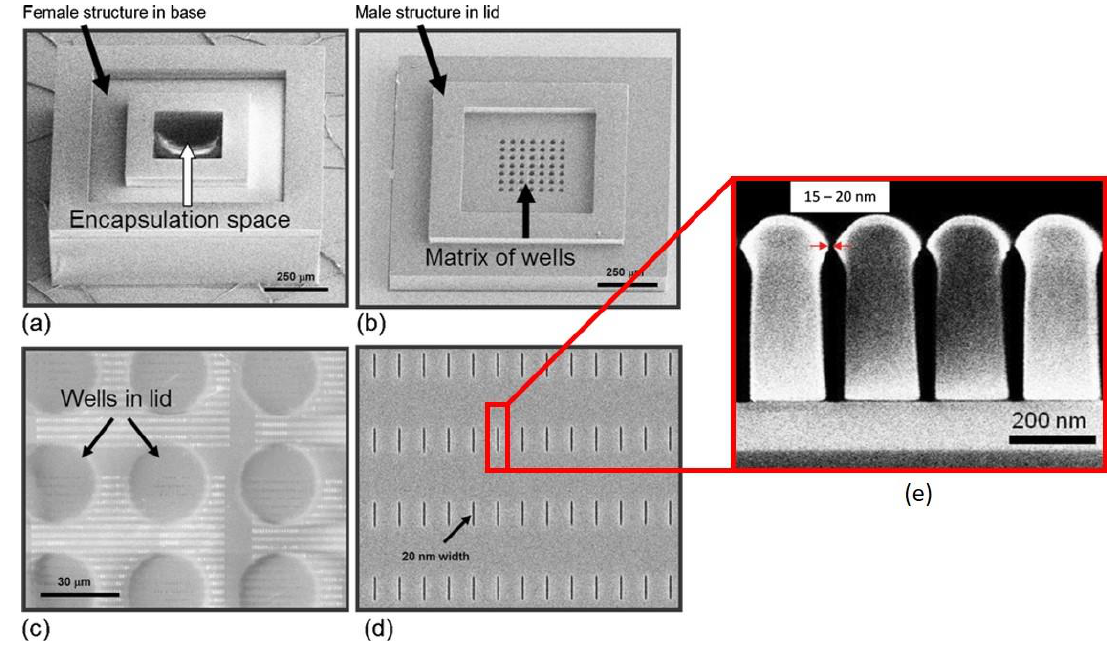
Figure 6. SEM images of the microcontainer’s hollowed cubic base ( a ), and lid that contains a matrix of wells that exposes a thin nanoporous membrane at the base of the wells ( b ). The thin nanoporous membrane has a nanopore array which is shown magnified in panel ( c ). The nanopores (enlarged view, d ) permit selective molecular transport through the membrane. Reprinted from Gimi et al. [51] with permission from Springer. ( e ) Cross section of the nanotrenches in SU-8. The topmost nanoslot opening is as narrow as 15 nm. Reprinted with permission from Kwon et al. [52] . Copyright 2009, American Vacuum Society.